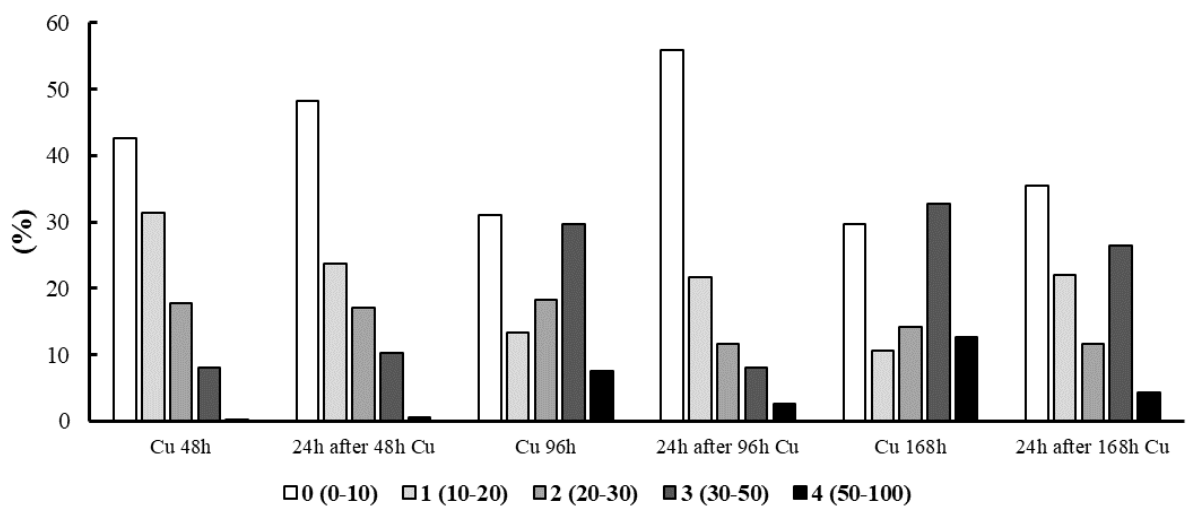
Figure 4. Distribution of individual classes of comets according to the level of DNA damage.